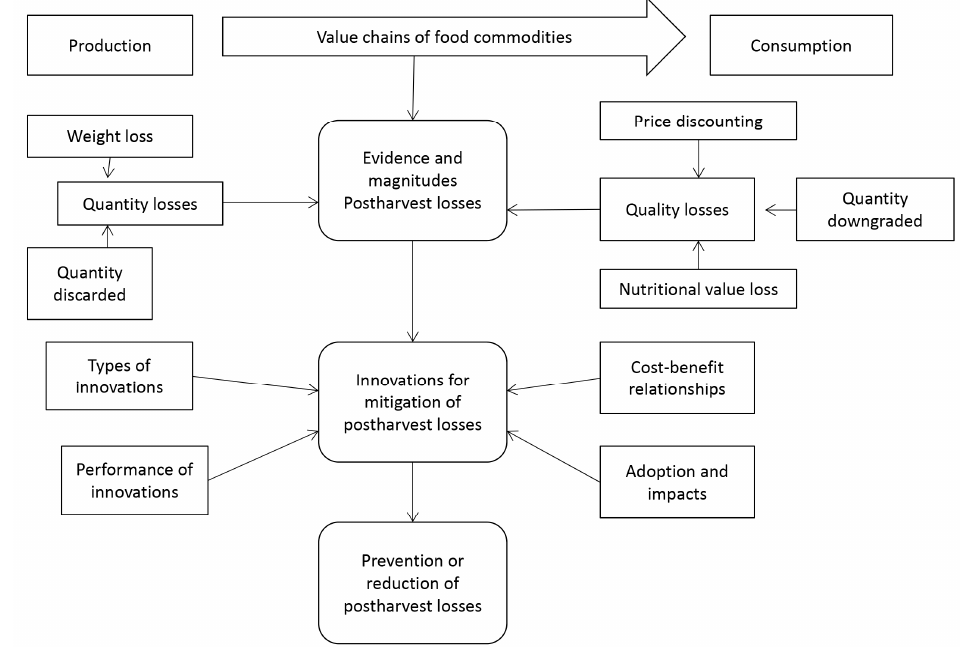
Figure 2. Post-harvest loss along a production to consumption food crop value chain